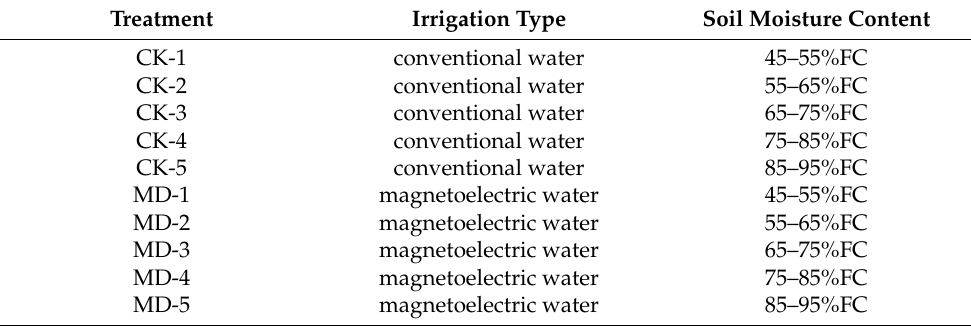
Table 1. Experimental treatments